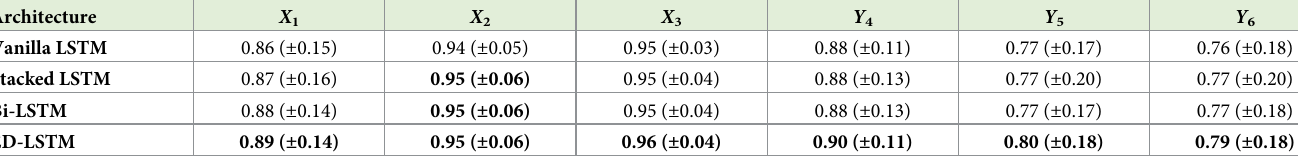
Table 5. Leave-one-out cross validation test evaluation based on the CC at the PWS and 5km.h -1 combined.